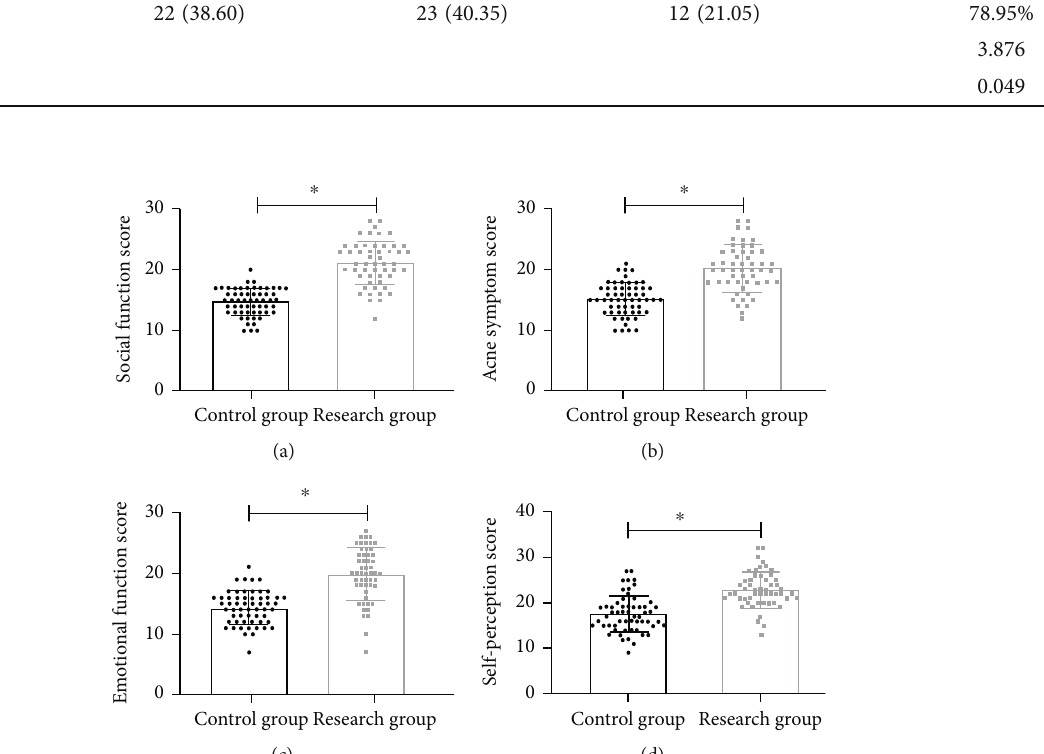
Figure 6: Comparison of prognostic life quality. (a) Social function score. (b) Acne symptom score. (c) Emotional function score. (d) Self- perception score. ∗ There is a di ff erence between the two